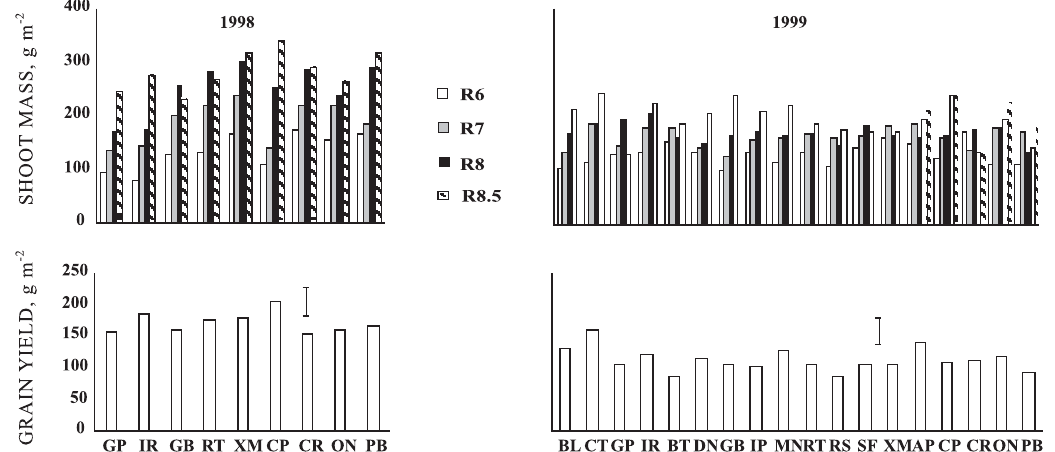
Figure 2. Shoot mass at four growth stages, and grain yield at maturity of common bean cultivars grown in two field experiments (1998 and 1999); means of four replications. R6, R7, R8, R8.5: growth stages of full flowering, pod setting, beginning of pod filling, and mid-pod filling, respectively. Vertical bars represent the least significant difference by Tukey test at 5 % level, and compare grain yields of cultivars. Cultivars: